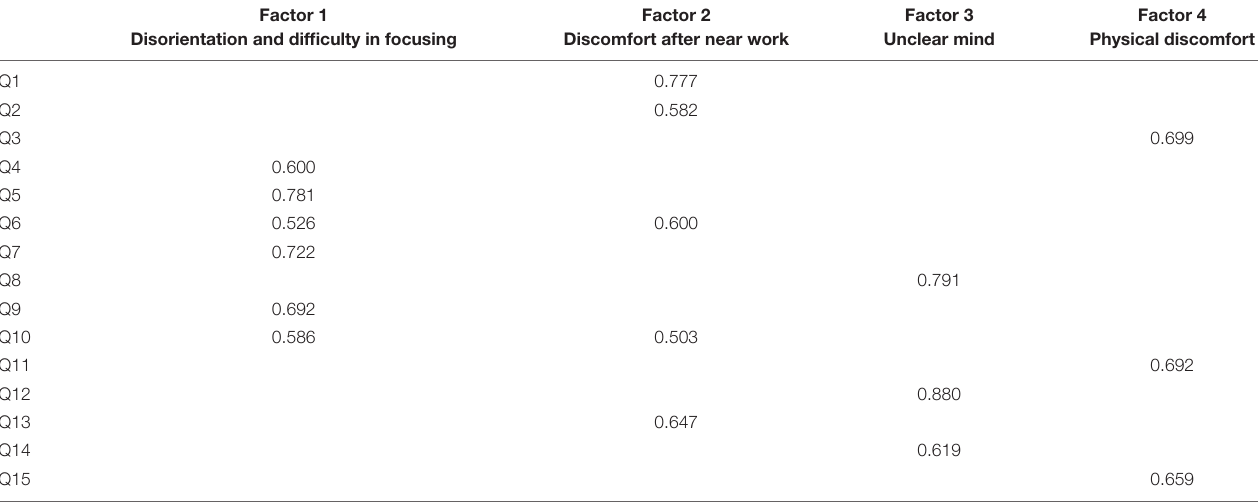
TABLE 1 | Factor analysis for 15 items in the questionnaire after Varimax with Kaiser Normalization. Factor 1 Disorientation and difficulty in focusing